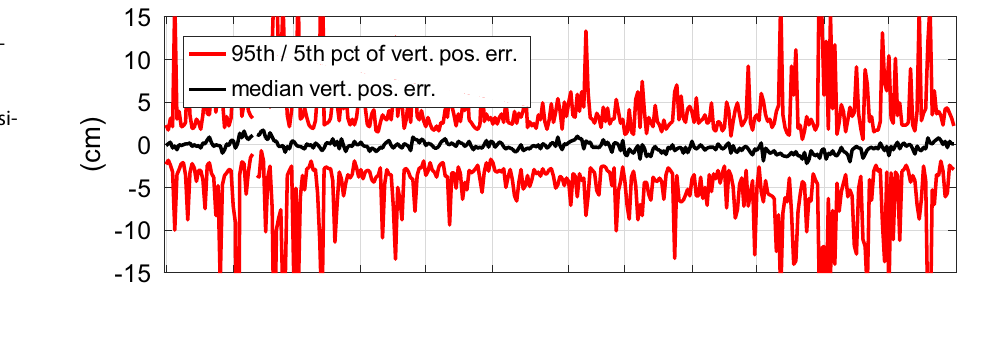
Fig. 2 Time series of daily statistics of position bias and noise for MSIM. Top panel: Median, 5th and 95th percen- tile of vertical position error. Bottom panel: Median and 95th percentile of vertical posi- tion standard